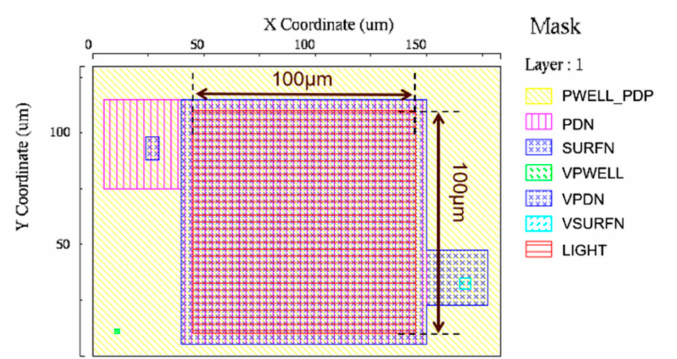
Figure 6. Mask configuration used for PD2 simulation. The central 100 µ m × 100 µ m area shows the light illumination region used in the spectral sensitivity simulation.